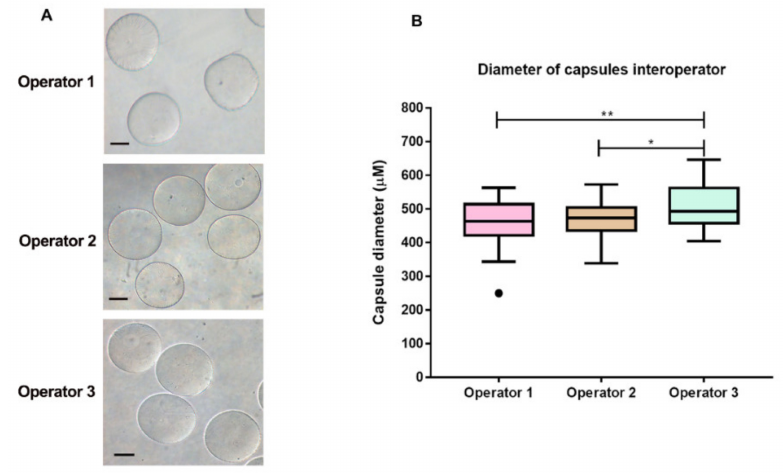
Figure 5. Reproducibility of the microcapsule production. ( A ) Morphological aspect of the capsules produced by the three operators in three independent experiments on di ff erent days. Scale bar presents 200 µ m. ( B ) Comparative evaluation of the diameter of the capsules produced by three blind operators using the cellular encapsulation equipment printed using a 3D printer. The box plots illustrate the production of microcapsules using the low cost device by the three di ff erent operators. Reproducibility of sodium alginate microcapsule production was verified microcapsules by three independent experiments with three di ff erent operators. Each operator produced a total of 20 capsules and the diameter of each was measured. Box plot explanation: upper horizontal line of box, 75th percentile; lower horizontal line of box, 25th percentile; horizontal bar within box, median; upper horizontal bar outside box, 90th percentile; lower horizontal bar outside box, 10th percentile. Circles represent outliers. The medians significantly ** = p < 0.005 and * = p < 0.05. To evaluate the cellular viability of HepG2 cells, labeling with a 2 µ M YO-PRO solution was carried out. Encapsulated living cells were unmarked, in contrast to the control with capsules containing dead